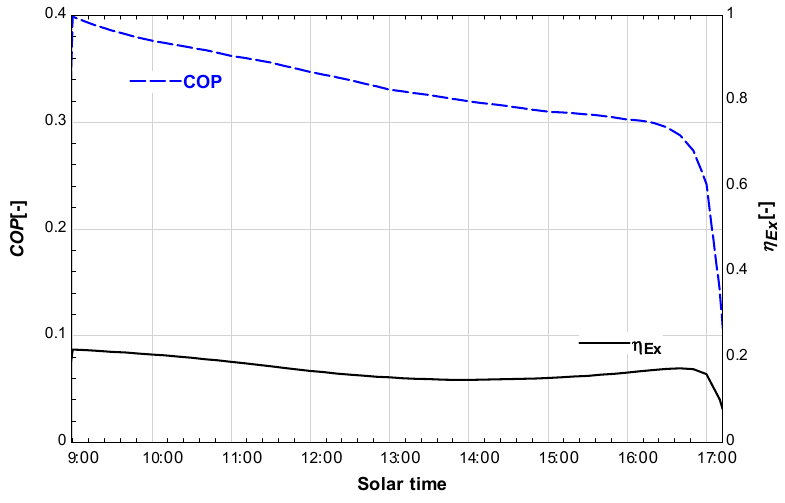
Figure 8. ACS coefficient of performance and exergetic efficiency.